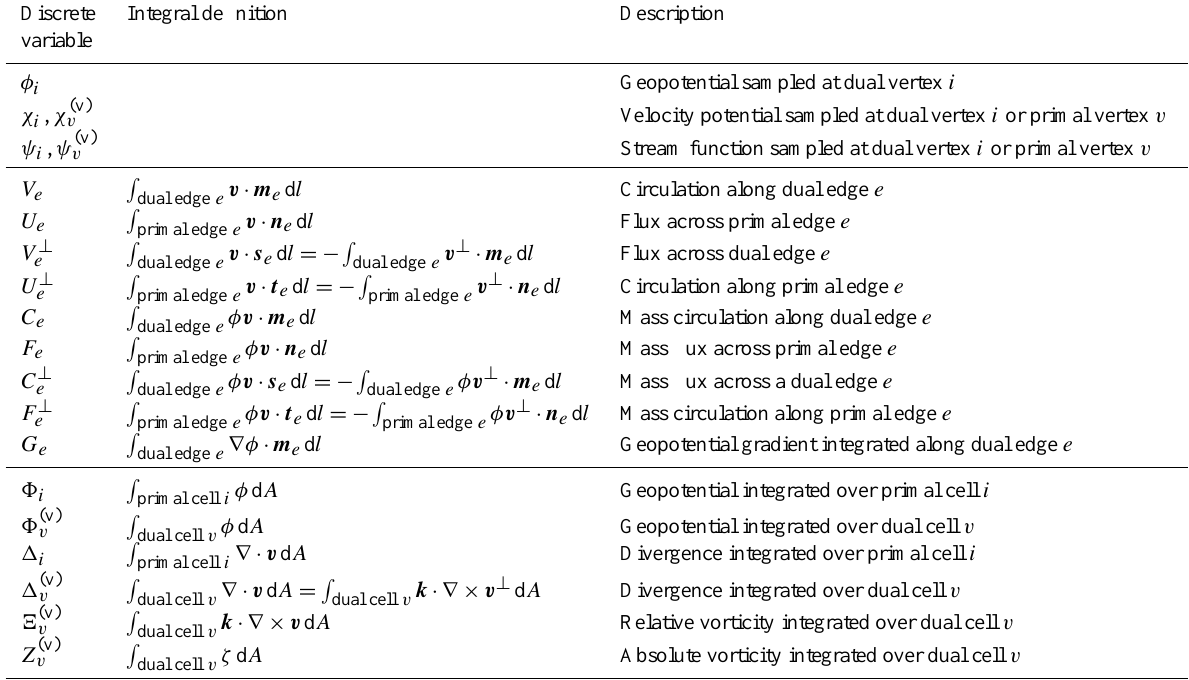
Table 2. Summary of the variables used in the discretization. Lower case variable names indicate values sampled at a point while upper case indicates integrated values. Superscript (v) indicates a value at a primal vertex or dual cell, to distinguish it from a variable of the same name at a dual vertex or primal cell. Here, n e is the unit normal to primal edge e and t e = k × n e ; m e is the unit tangent to dual edge e and s e = k × m e